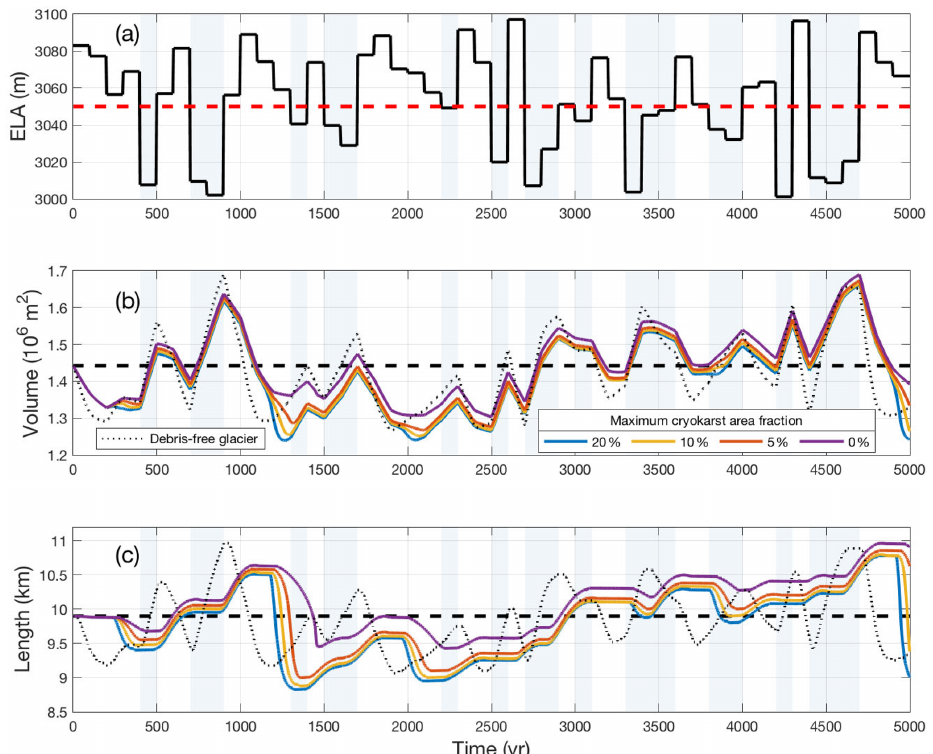
Figure 9. Random climate forcing (a) and the corresponding transient volume response (b) and transient length response (c) for glaciers of different maximum cryokarst fraction λ m . The dashed lines represent (a) the mean value climate of ELA = 3050m and the corresponding steady-state (b) volume and (c) length. The light blue background shading represents temporal periods during which the climate forcing is colder than the mean climate. In all cases, the debris concentration is c = 0 . 25%, and the cryokarst driving stress thresholds are τ + = and τ − d